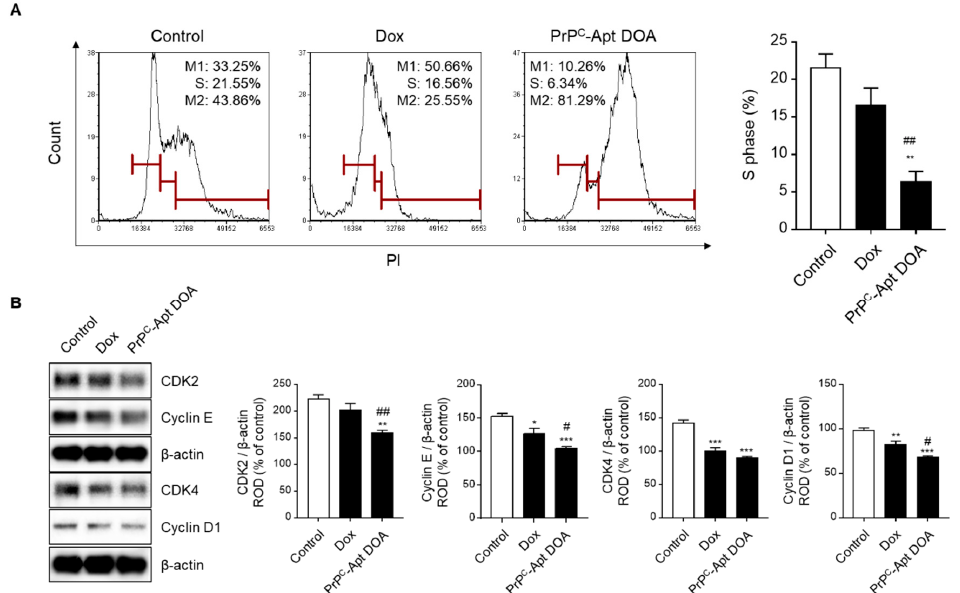
Figure 6. PrP C -Apt DOA efficiently inhibit the proliferation of CRC cells to a greater extent than free Dox. ( A ) Cell cycle analysis of SNU-C5 cells post treatment with free Dox and PrP C -Apt DOA ( n = 3). ( B ) Western blot analysis of SNU-C5 cells for CDK2, cyclin E, CDK4, and cyclin D1 post treatment with free Dox and PrP C -Apt DOA ( n = 3). Protein levels were determined using densitometry relative to β -actin. The values represent mean ± SEM. * p < 0.05, ** p < 0.01, *** p < 0.001 vs. control; # p < 0.05, ## p < 0.01 vs. free Dox.